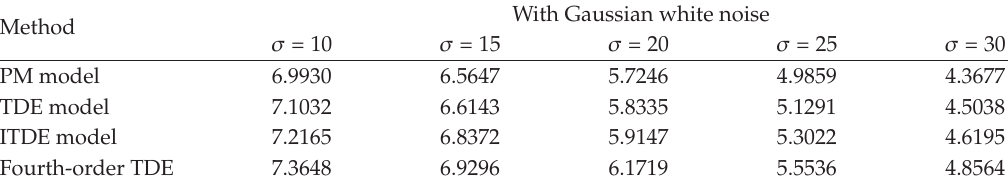
Table 2: ISNR (cid:3) in dB (cid:4) values for “license plate” image using di ff erent methods across five noise